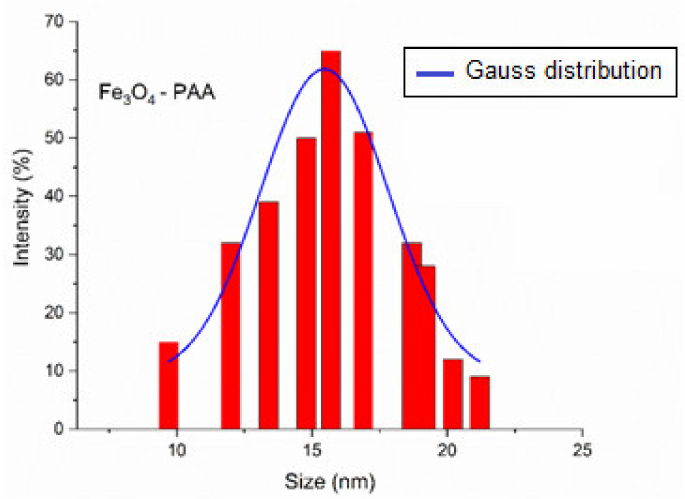
Figure 9. DLS for Fe 3 O 4 -PAA nanoparticles.